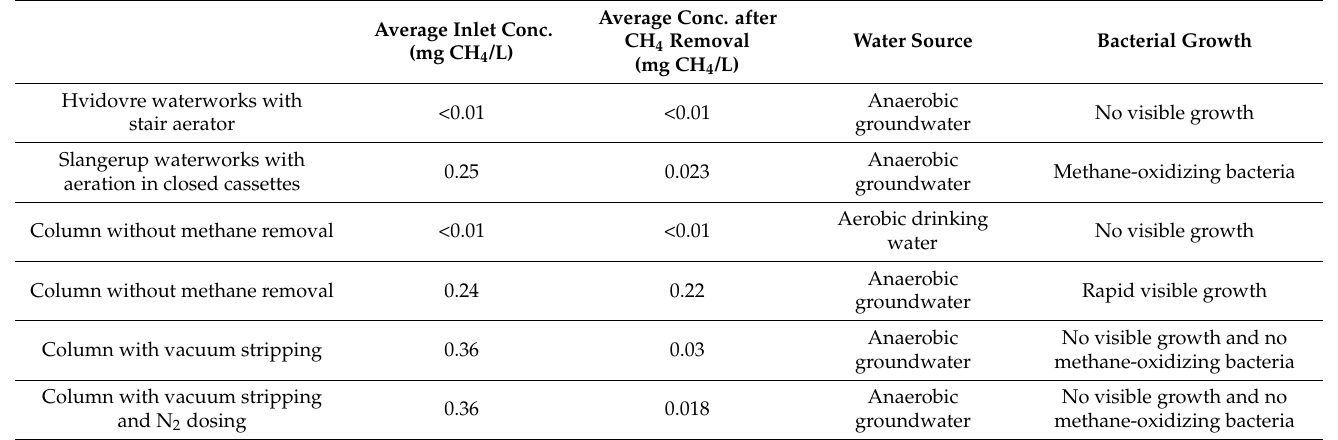
Table 2. Summary of effect of methane concentration and removal on bacterial growth in the different